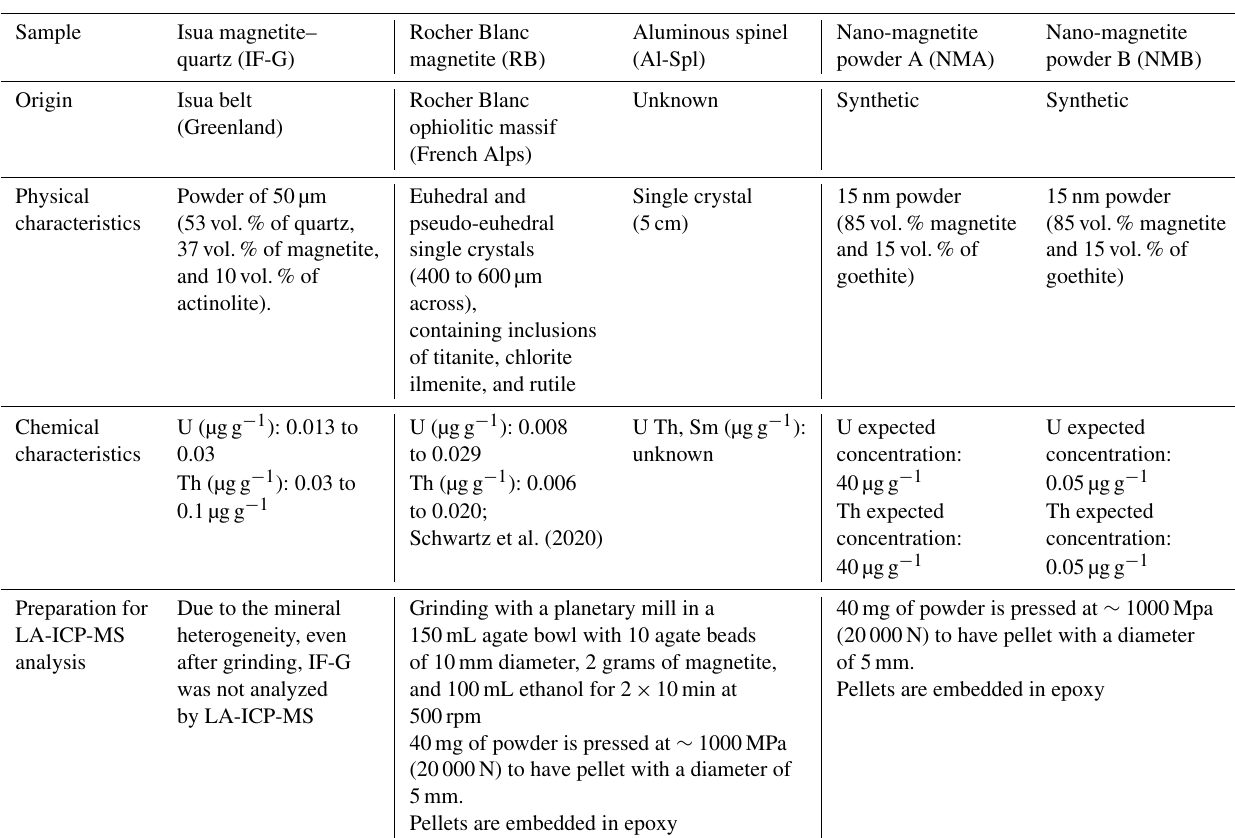
Table 1. Sample description.